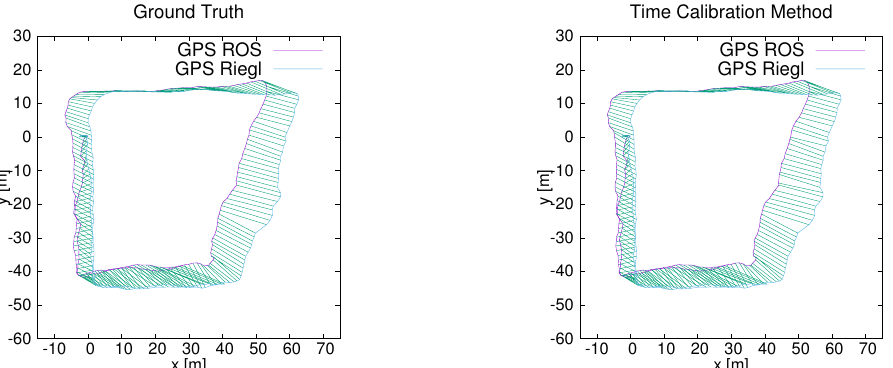
Figure 14. Data synchronization results. ( Left ): Synchronizing data by ground truth. ( Right ): Synchronizing data by the proposed time-calibration method. The trajectory is from the ZAEG data set.